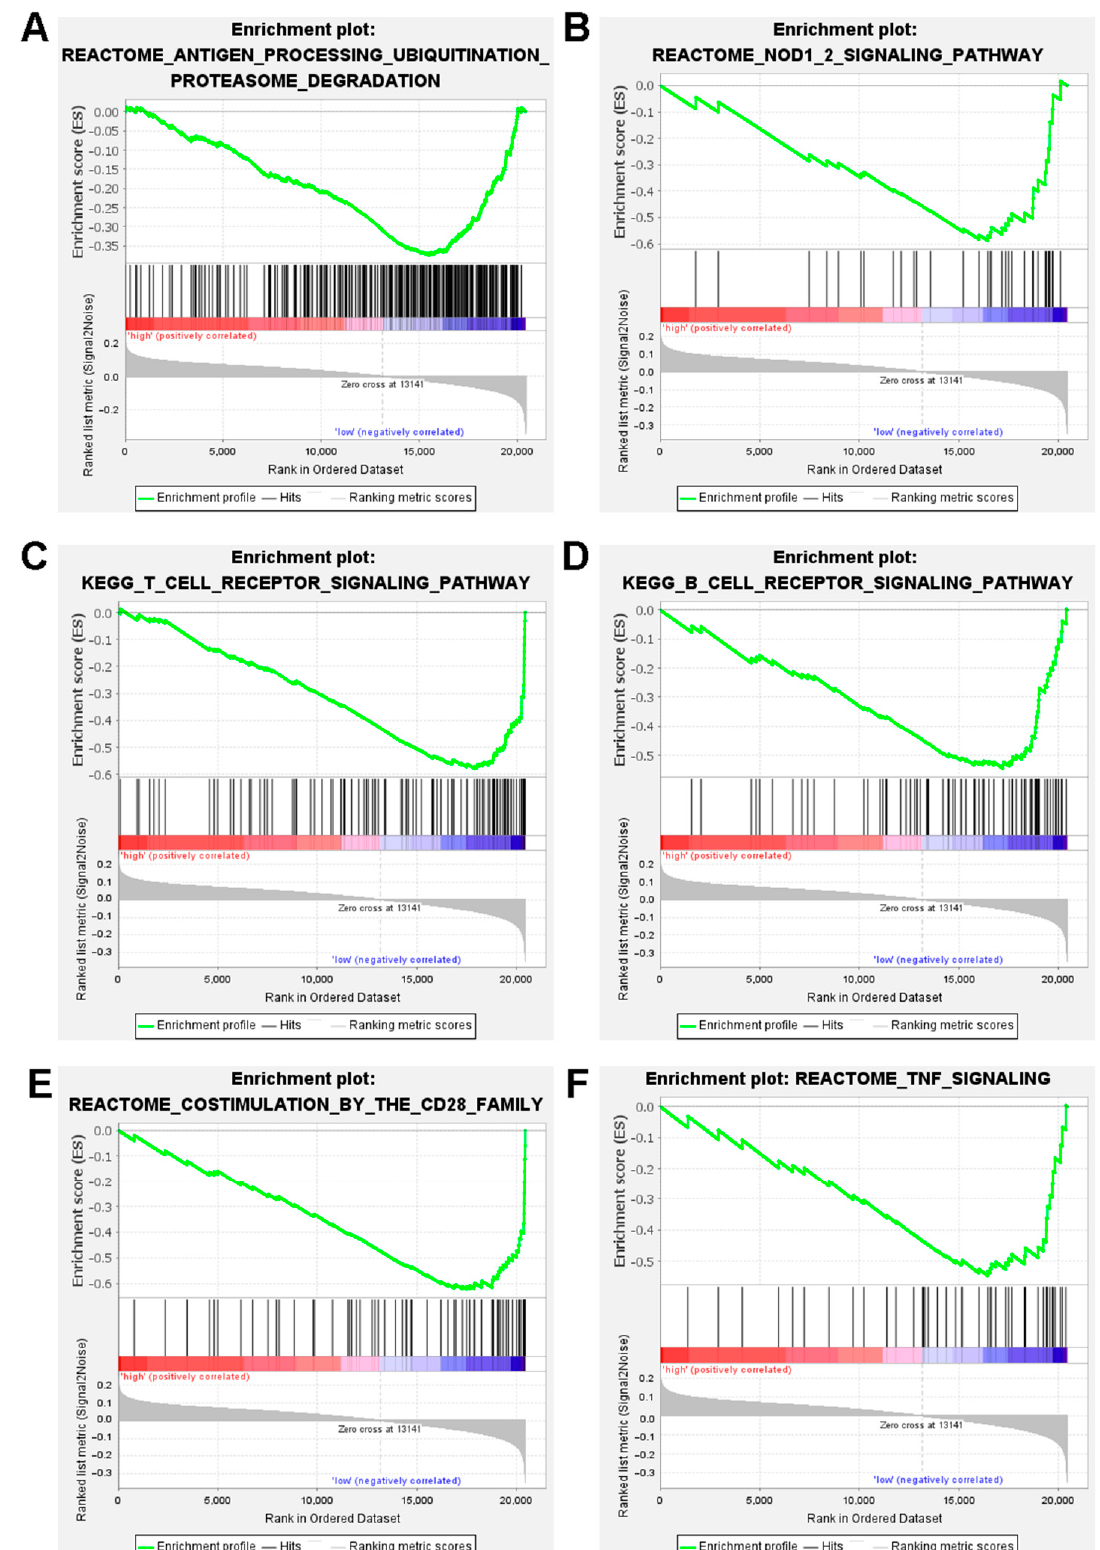
Figure 6. Analysis of the gene set and function enrichment of the ICD-related gene signature in high- and low-risk groups. Antigen processing ubiquitination proteasome degradation pathways ( A ), signaling by NOD 1/2 ( B ), signaling by T cell receptors ( C ), signaling via B cell receptors ( D ), the CD28 family’s costimulation ( E ), and TNF signaling ( F ) are significantly increased in the low-risk